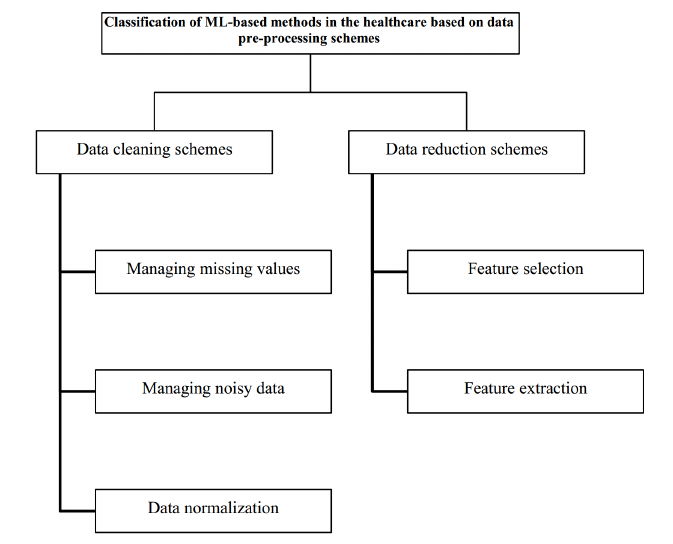
Figure 7. Classification of ML-based schemes in terms of data pre-processing